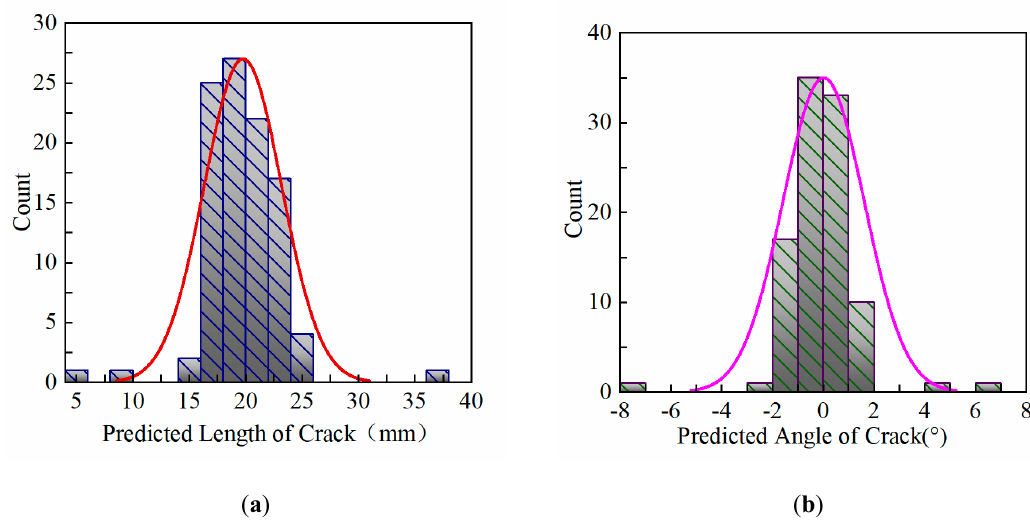
Figure 19. Histogram of crack length and angle prediction values in the experiment: ( a ) Length; ( b ) Angle.